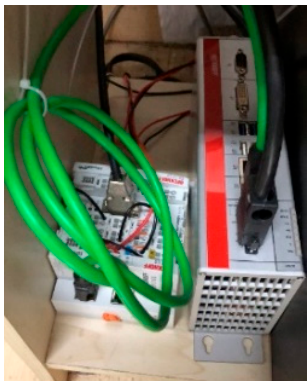
Figure 5. The C6920 controller.